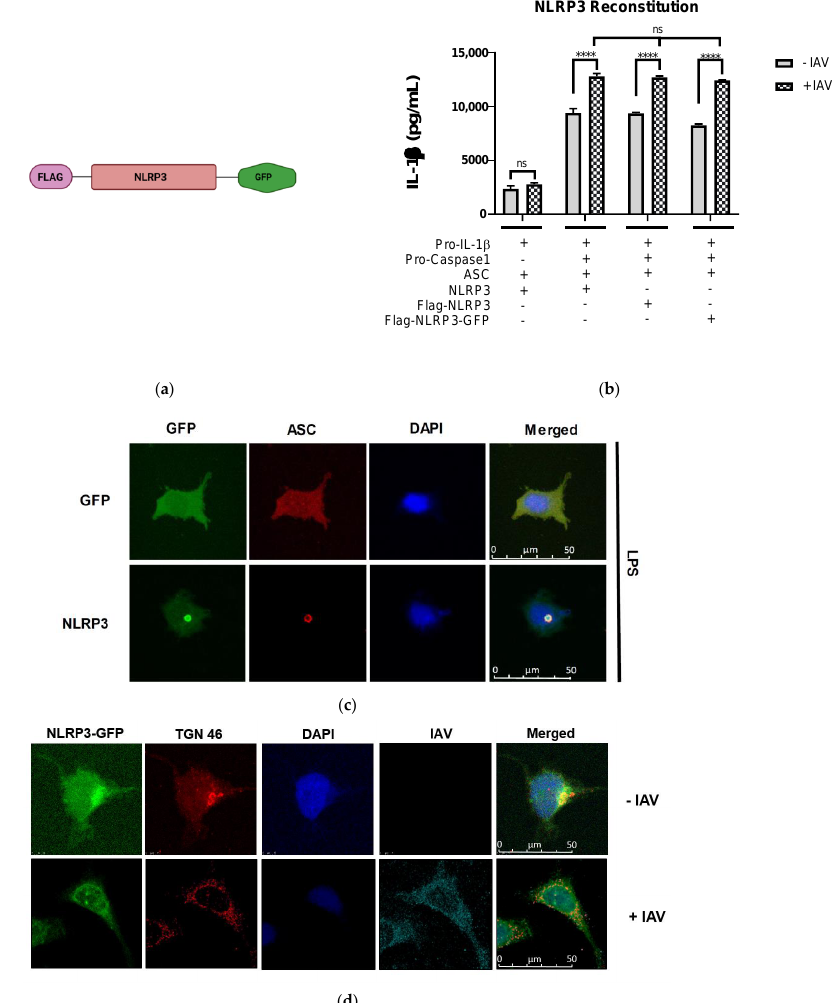
Figure 1. IAV infection induces the formation of dispersed trans-Golgi network. ( a ) Schematic representation of Flag-NLRP3-GFP construct. ( b ) HEK293T cells were transfected with different combinations of plasmids expressing porcine NLRP3, ASC, pro-caspase-1, and pro-IL-1β as indicated. At 12 h.p.t., the cells were mock-infected or infected with Sk02 at an MOI of 10. Porcine IL-1β from the cell-free supernatants at 12 h.p.i was measured by ELISA (two-way ANOVA; **** p < 0.0001; ns- Not significant). ( c ) HeLa cells were co-transfected with ASC together with either GFP or NLRP3-GFP and were stimulated with LPS (200 ng/mL) for 80 min. The cells were fixed, permeabilized, blocked, and probed with appropriate antibodies, followed by DAPI staining. GFP/NLRP3-GFP (green), ASC (red), and nucleus (blue) were visualized by confocal microscopy. Scale bar, 50 μm. ( d ) HeLa cells expressing NLRP3-GFP were infected with Sk02 at an MOI of 10. At 80 m.p.i, the cells were subjected to immunofluorescence for NLRP3-GFP (green), TGN (red), IAV (cyan), and nucleus (blue). Scale bar, 50 μm.